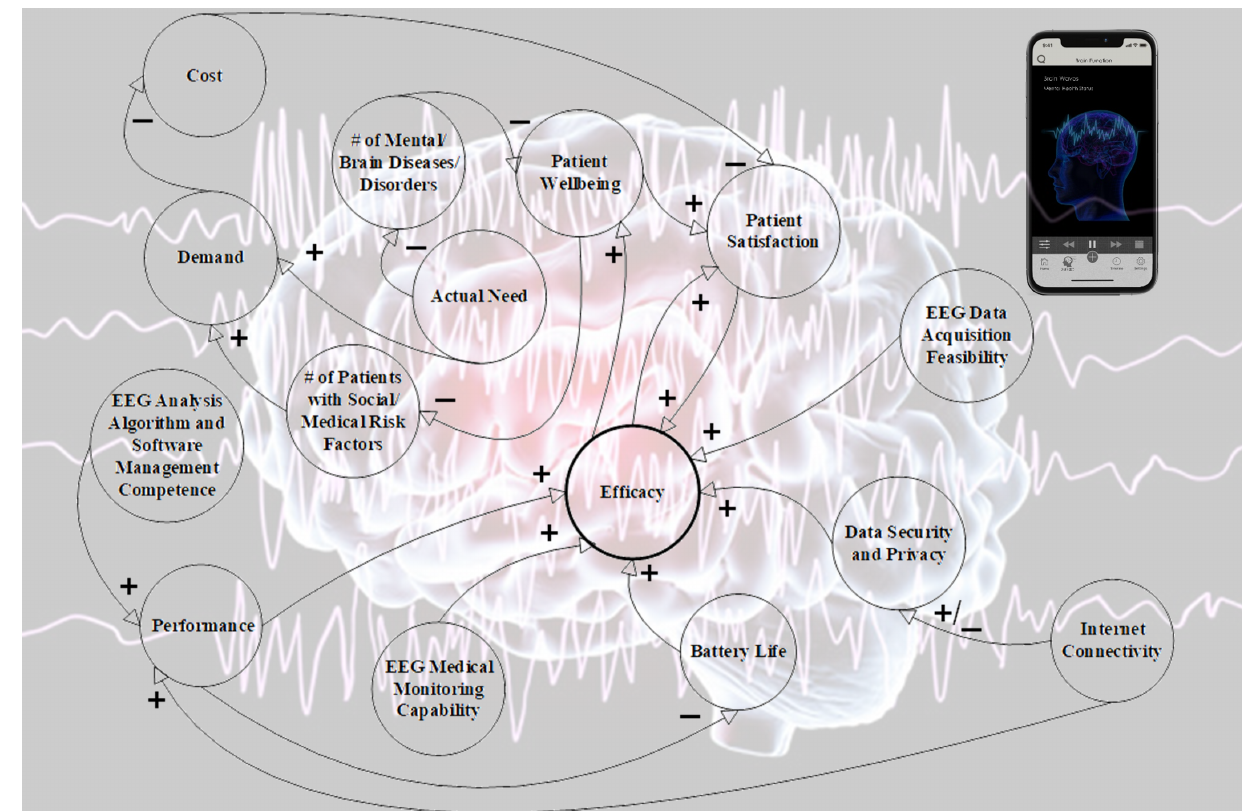
Figure 2. Causal model of a smartphone-based EEG (Electroencephalography) monitoring